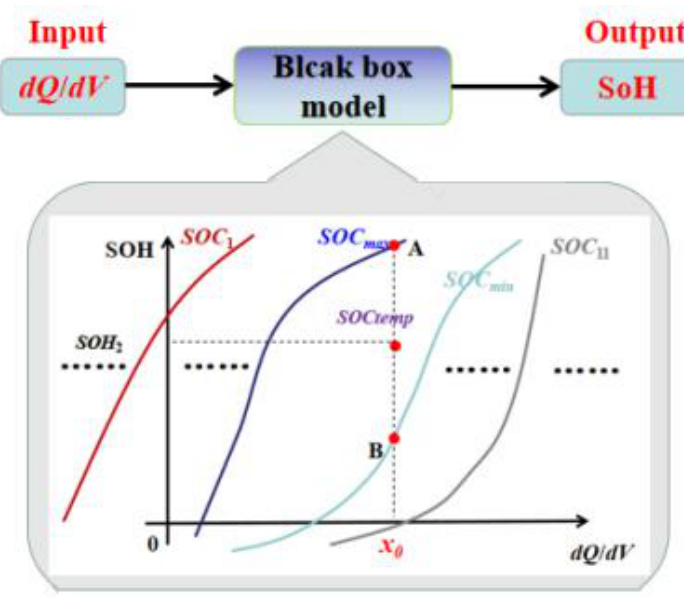
Figure 4. The black box model of SoH estimation (the input is dQ / dV , output is estimated SoH and the black box algorithm relies on fitting curves).